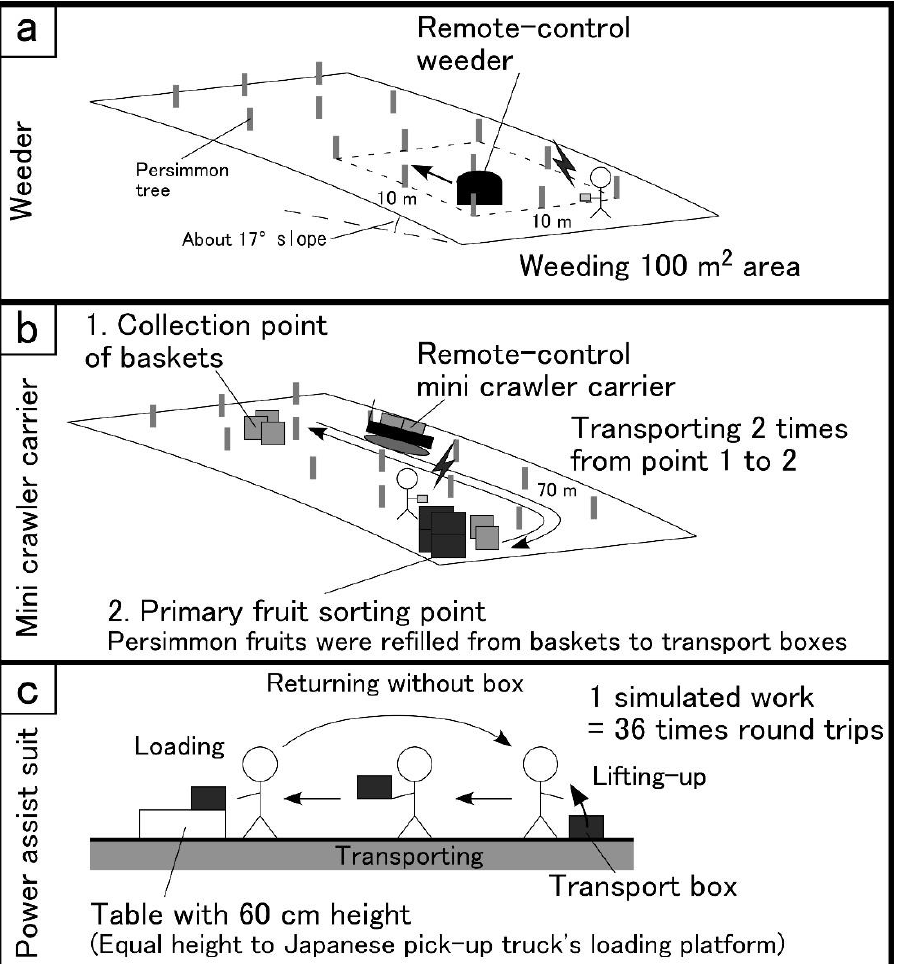
Figure 5. Experimental settings adopted in persimmon cultivation: ( a ) experimental settings for weeder; ( b ) experimental settings for mini crawler carrier; ( c ) experimental settings for power assist suit.